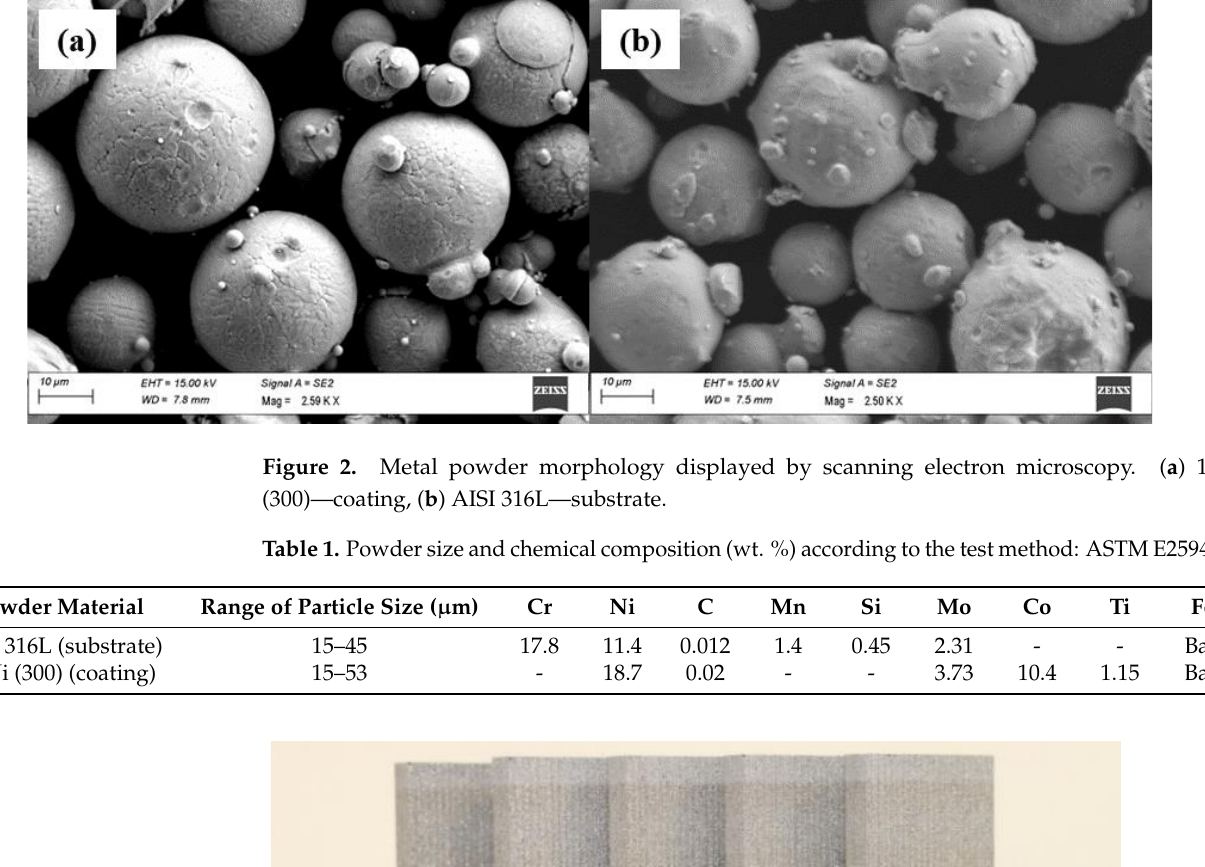
Figure 3. AISI 316L substrates manufactured by using L-PBF technology.